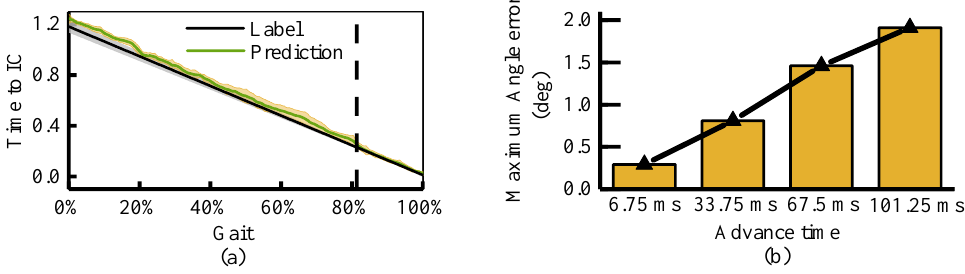
Figure 10. The results of motion prediction. ( a ) The results of predicted time to heel strike. The green curve is the prediction result, and the black curve is the actual time to hell strike. ( b ) The mean of maximum angle error for four groups of joint trajectory